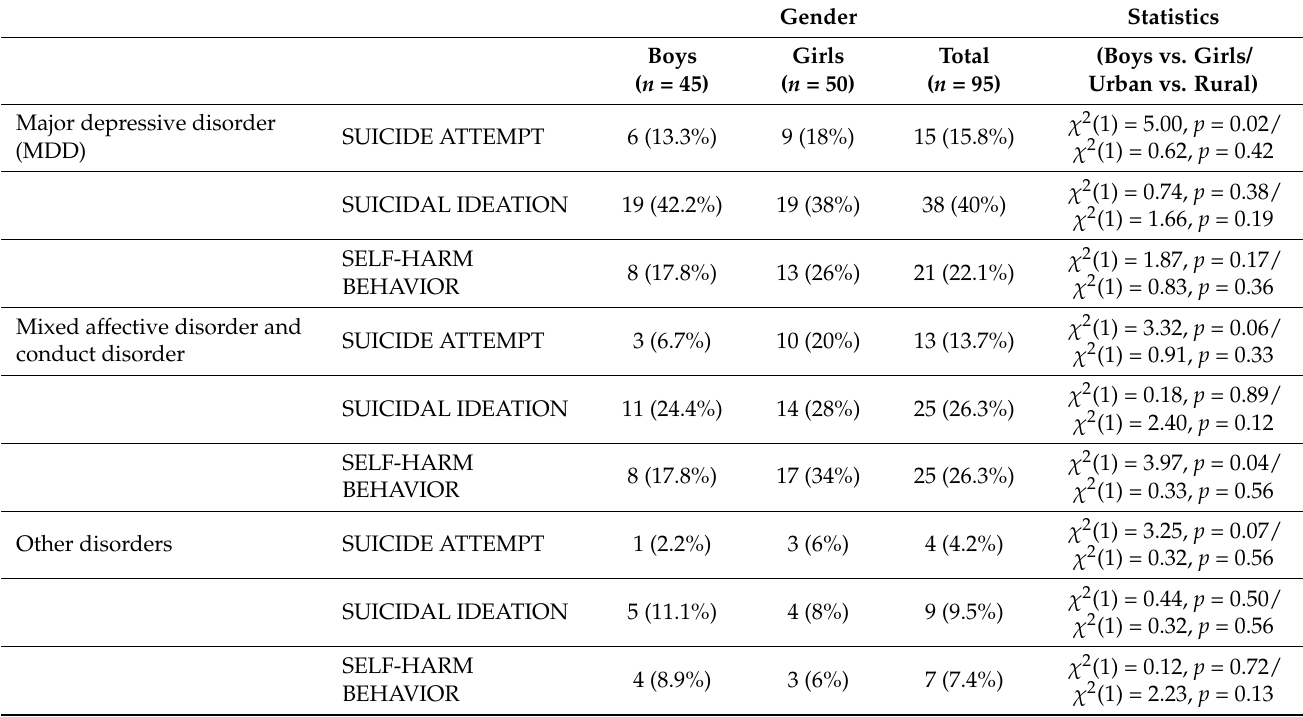
Table 2. Cross-tabulation of gender and environment vs. clinical variables. Gender